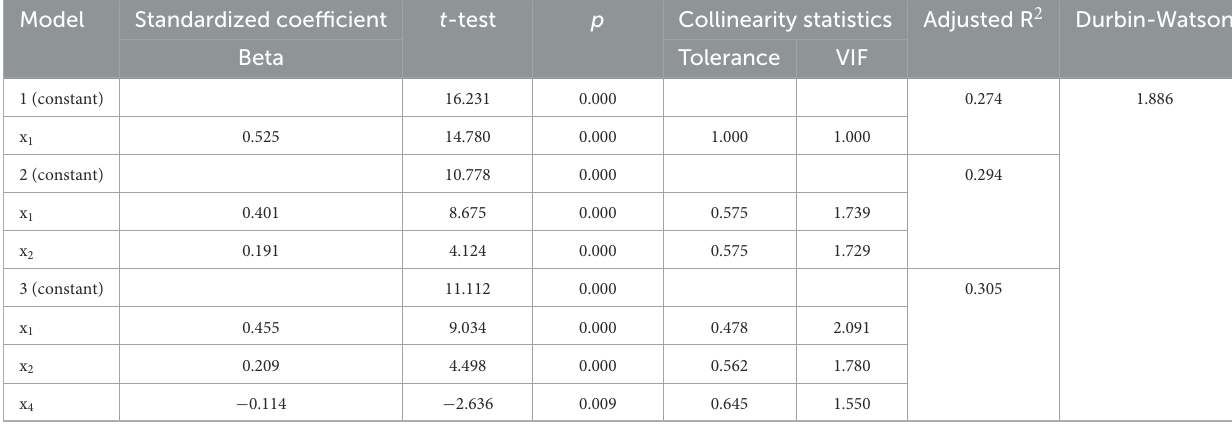
TABLE 7 Analysis of the overall satisfaction degree of the construction in the aging community.